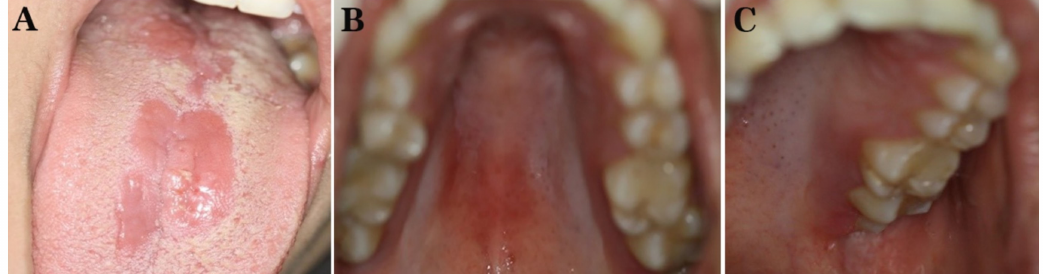
Figure 3. Patient 1. Clinical examination one week after the onset of the antifungal therapy: significant improvement of the lesions on the dorsal tongue ( A ), hard palate ( B ), and left tuberosity ( C ).